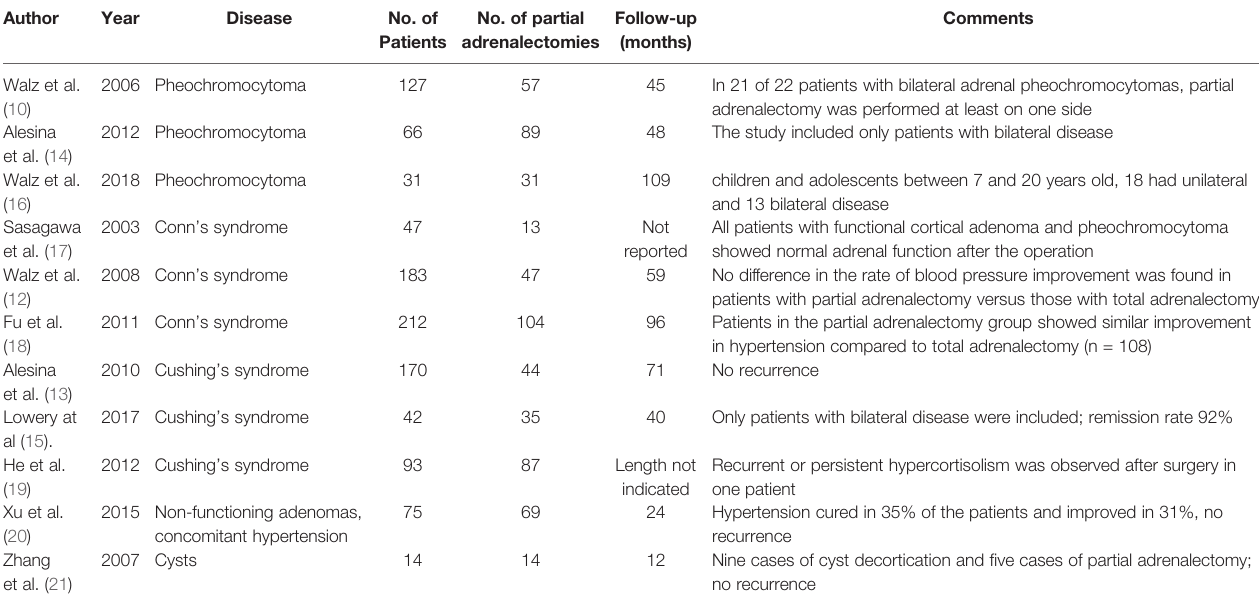
Figure 2 . The dissection starts on the upper pole of the kidney that is freed from the adhesions to the retroperitoneal fatty tissue. The kidney is gently retracted caudally and medially to expose the lower pole of the adrenal gland. The dissection is